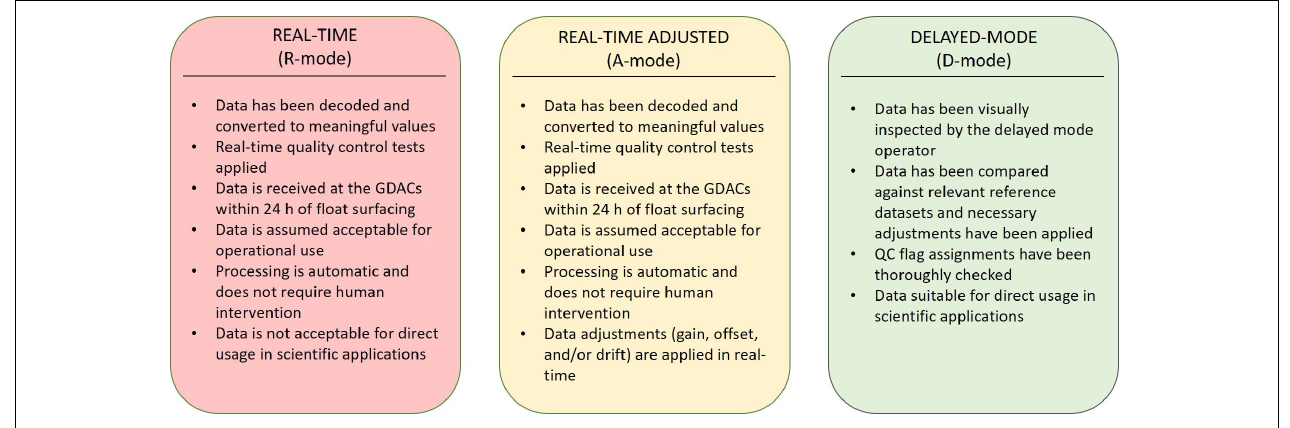
FIGURE 6 | Summary of data mode characteristics.